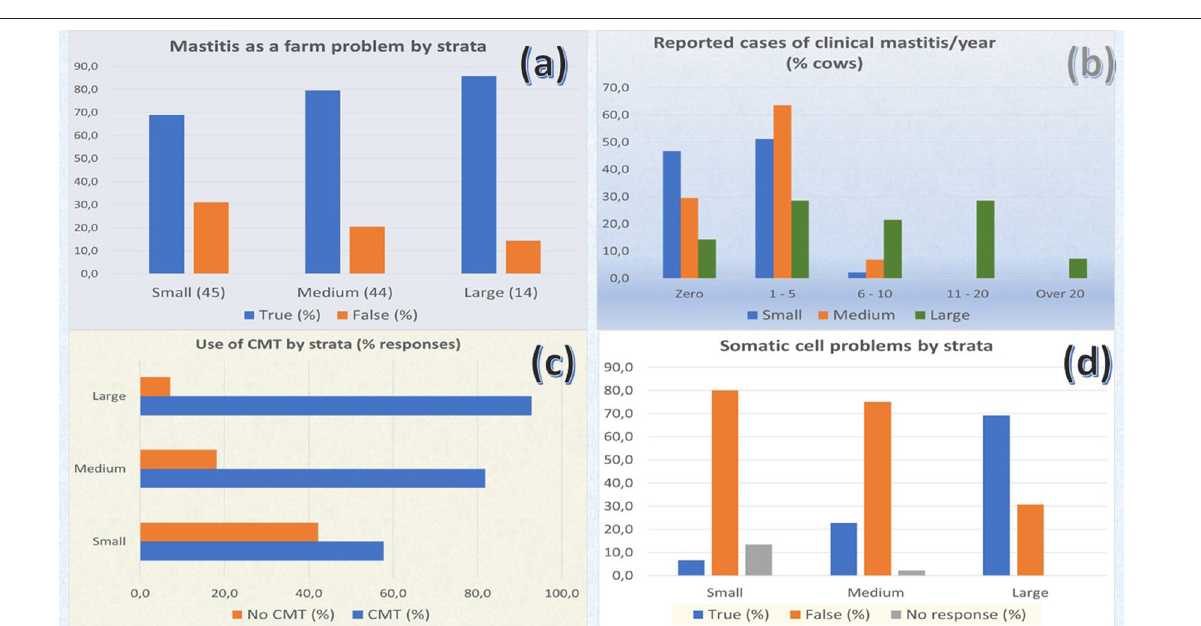
percentage of estimated milk production losses due to SCM per farm fluctuated from 0% to 12.8%, but a higher percentage of losses was observed in the medium sized farms, ranging from 1.3% to 13.5%. High dispersion of percentage of losses among farms was found irrespective of the stratum, while the scattering of values was less extended in the large